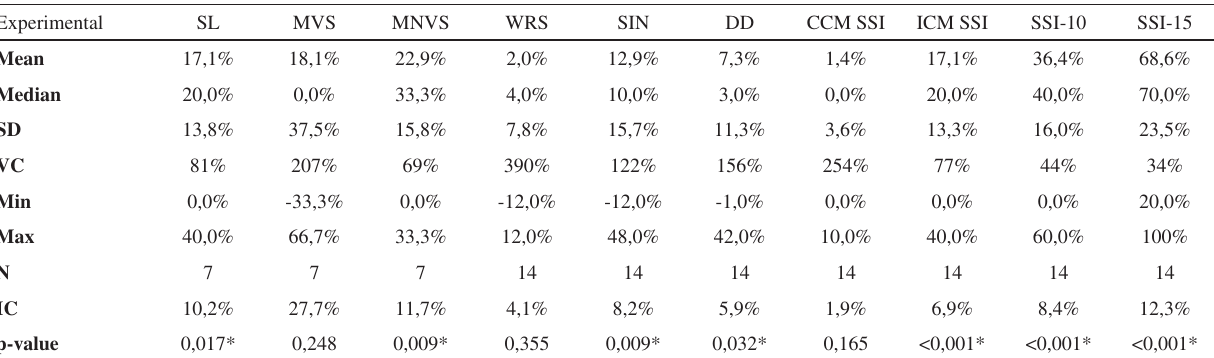
Table 3 - Amount of improvement in behavioral auditory processing tests for the experimental group comparing pre- and post-training evaluations